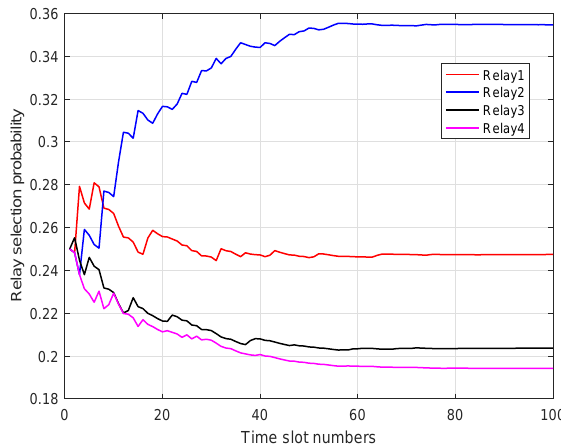
Figure 5. Relay selection probability.